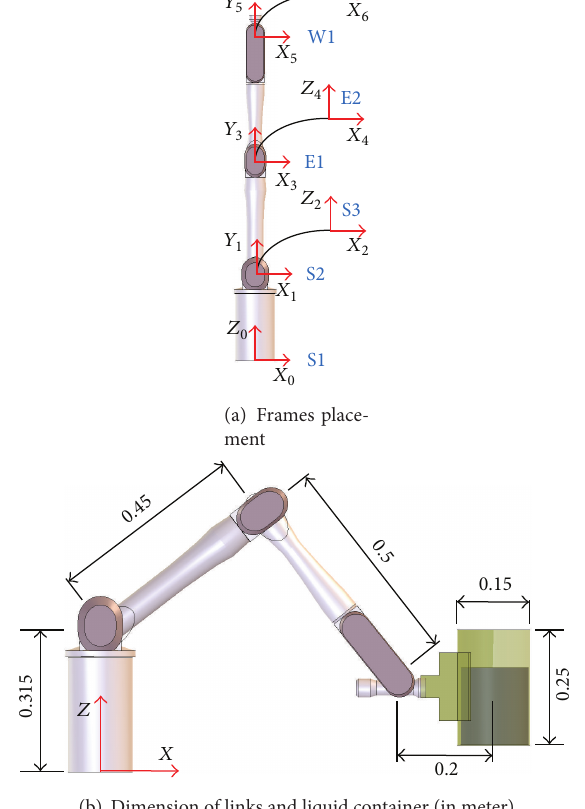
Figure3:(a)Framesplacementand(b)dimensionoftheliquidcon- tainer system and the base